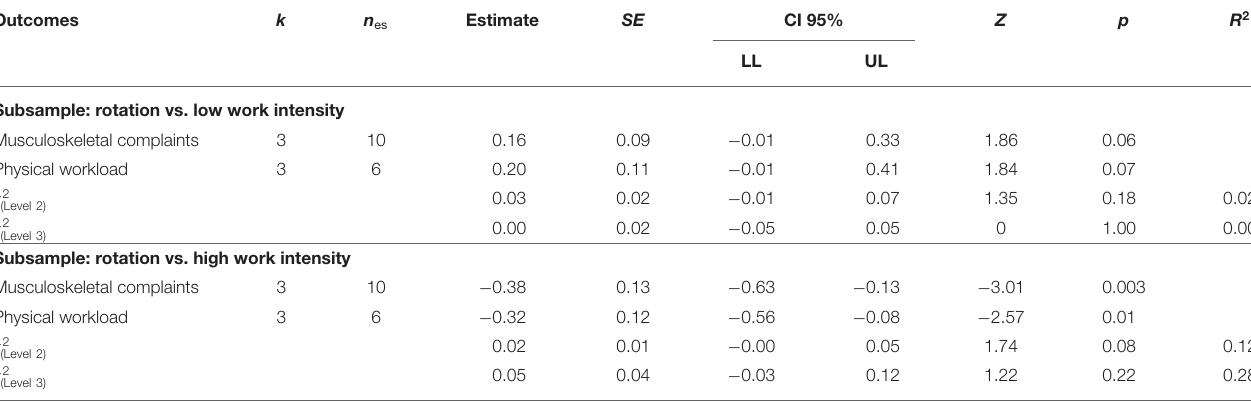
TABLE 2 | Relationships between job and task rotation and physical health outcomes subdivided according to work intensity of reference